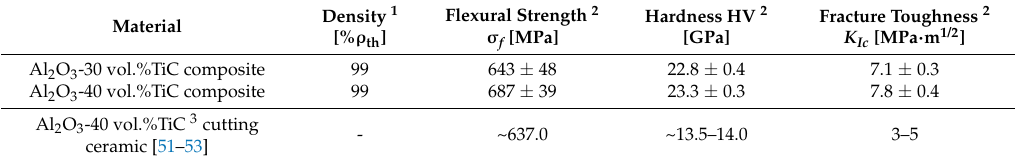
Figure 3. The Al 2 O 3 ‐ 40 vol.% TiC composite: ( a ) polished surface of the sample; ( b ) combination map for phases in a composite; ( c ) distribution map of X ‐ ray of individual element Ti K α ; ( d ) distribution map of X ‐ ray of individual element Al K α . Table 1. Mechanical properties of Al 2 O 3 ‐ TiC composites with 30 and 40 vol.% TiC.